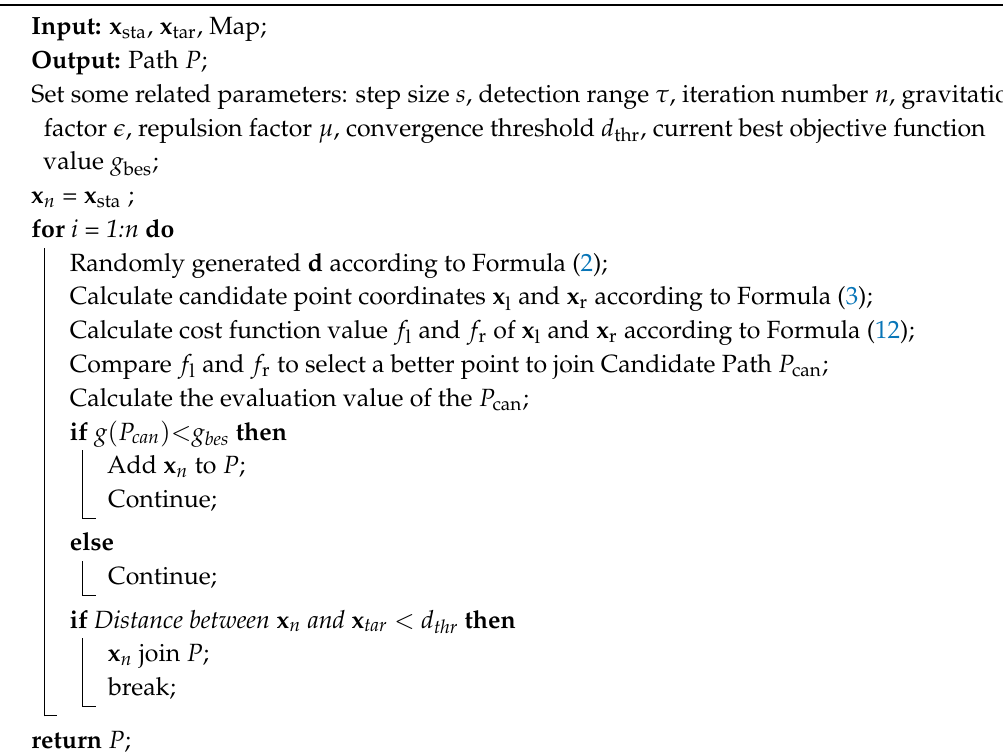
Algorithm 1: BAS-APF design process